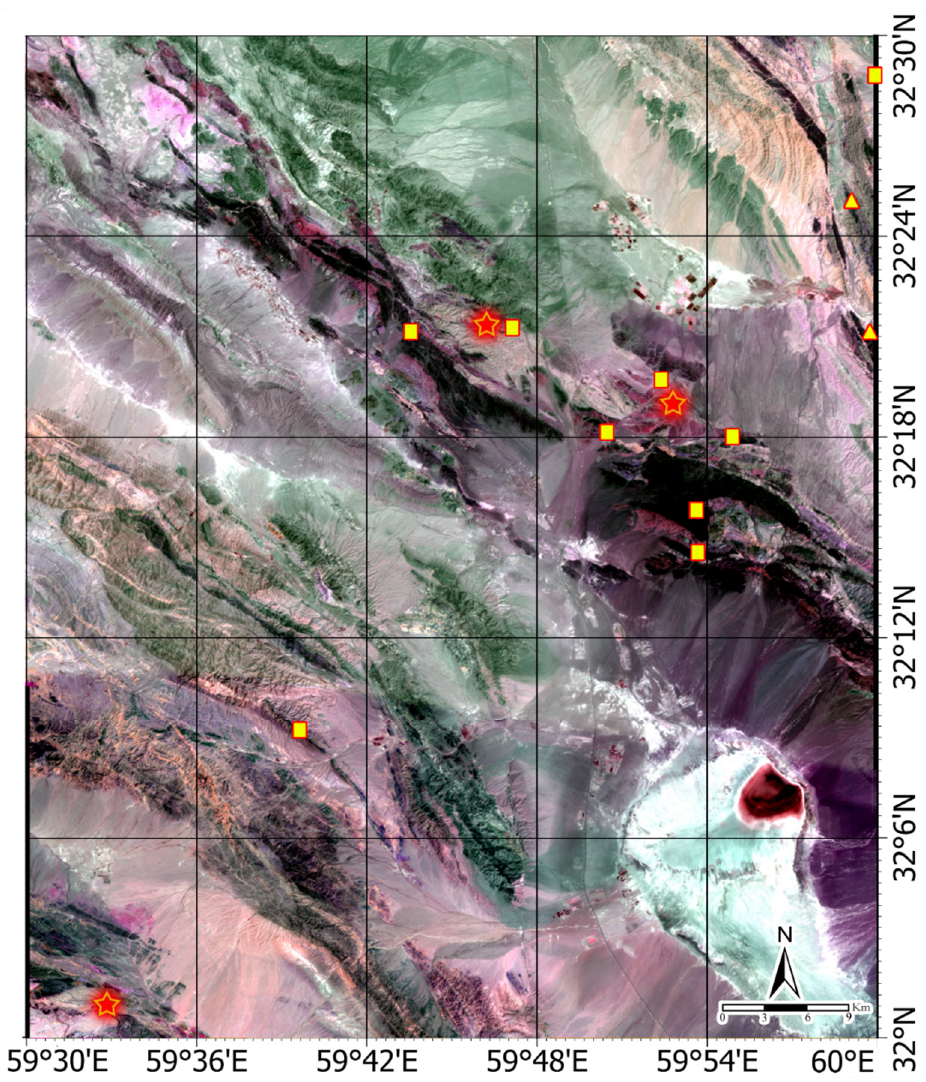
Figure 5. False Color Combination (FCC) of bands 4, 8 and 6 as RGB color composite for Sahlabad mining area. The location of copper deposits, old mines and indices are shown with red stars and yellow triangles and cubes, respectively.